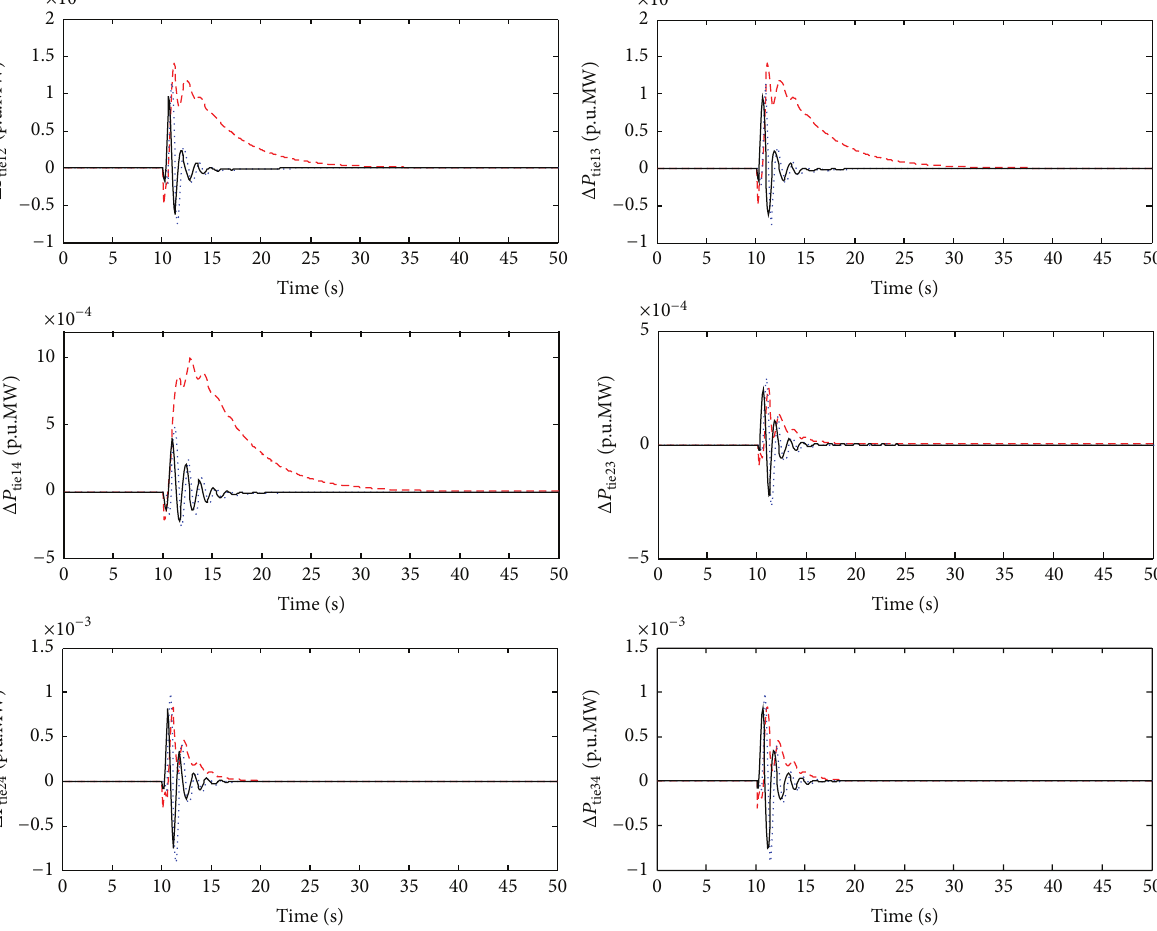
Figure 12: Response of tie-line active power deviation in Case 2: distributed MPC (solid line), centralized MPC (dotted line), and decentralized MPC (dashed